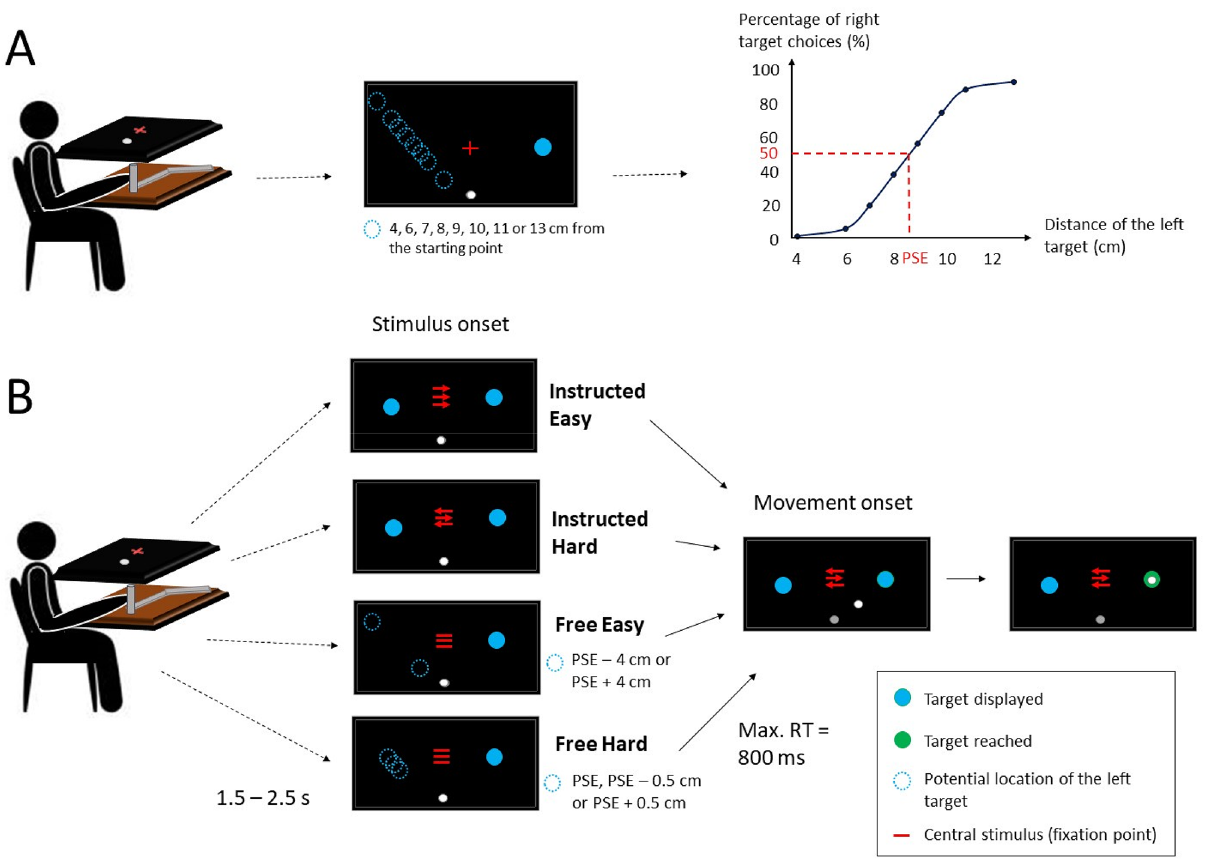
Figure 1. Experimental design. ( A ) Preliminary test. On the left, the scheme represents participants’ placement and the manipulandum used. Participants were asked to grasp a handle (gray cylinder) located below the screen with their right hand, which position was displayed on the screen in real time with a cursor (white dot). Black rectangles are schematic representations of the screen displayed in front of participants. The trial started with the appearance of a red fixation cross and the starting point (gray dot). Once participants placed their cursor into the starting point for 1.5 to 2.5 s, two targets appeared on the screen. The location of the left target varied across trials (all possible locations are represented with the dotted blue circles). The percentage of right target choices as a function of left target locations was fitted with a psychometric function to extract the PSE (i.e., left target location corresponding to the 50th percentile of right target choice). ( B ) Test. Participants’ placement was similar to the one used in the preliminary test. Trial timeline was also similar, except that at target onset the red fixation cross turned into a stimulus indicating the choice context (arrows: instructed, lines: free) and the direction of the target to reach in the case of an instructed choice (direction indicated by the central arrow). Movement onset was considered as the first time point at which the position of the cursor was located outside of the starting point. If the cursor ended inside of one of the two presented targets in free choices or inside of the target indicated by the central arrow in the case of instructed choices, the selected target turned